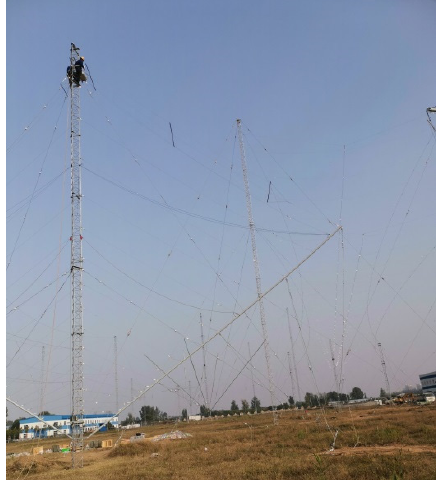
Figure 10. Fabricated miniaturized transmitting LPDA.